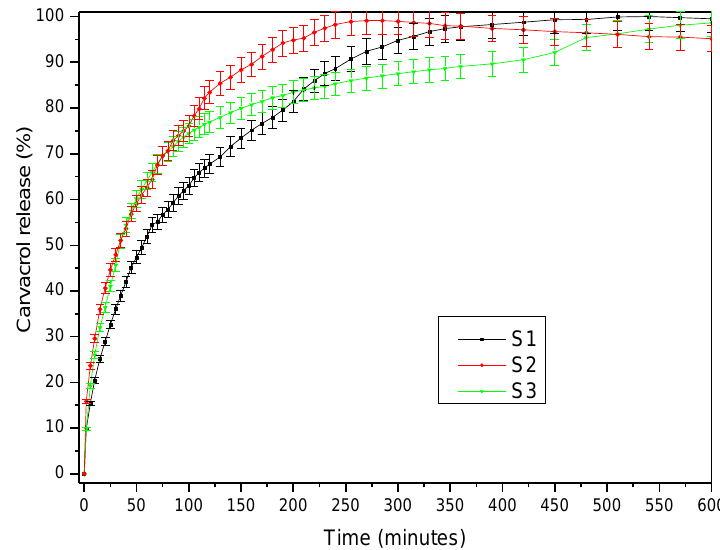
Figure 9. The release profile of carvacrol from PITAU–Alg hydrogel network.